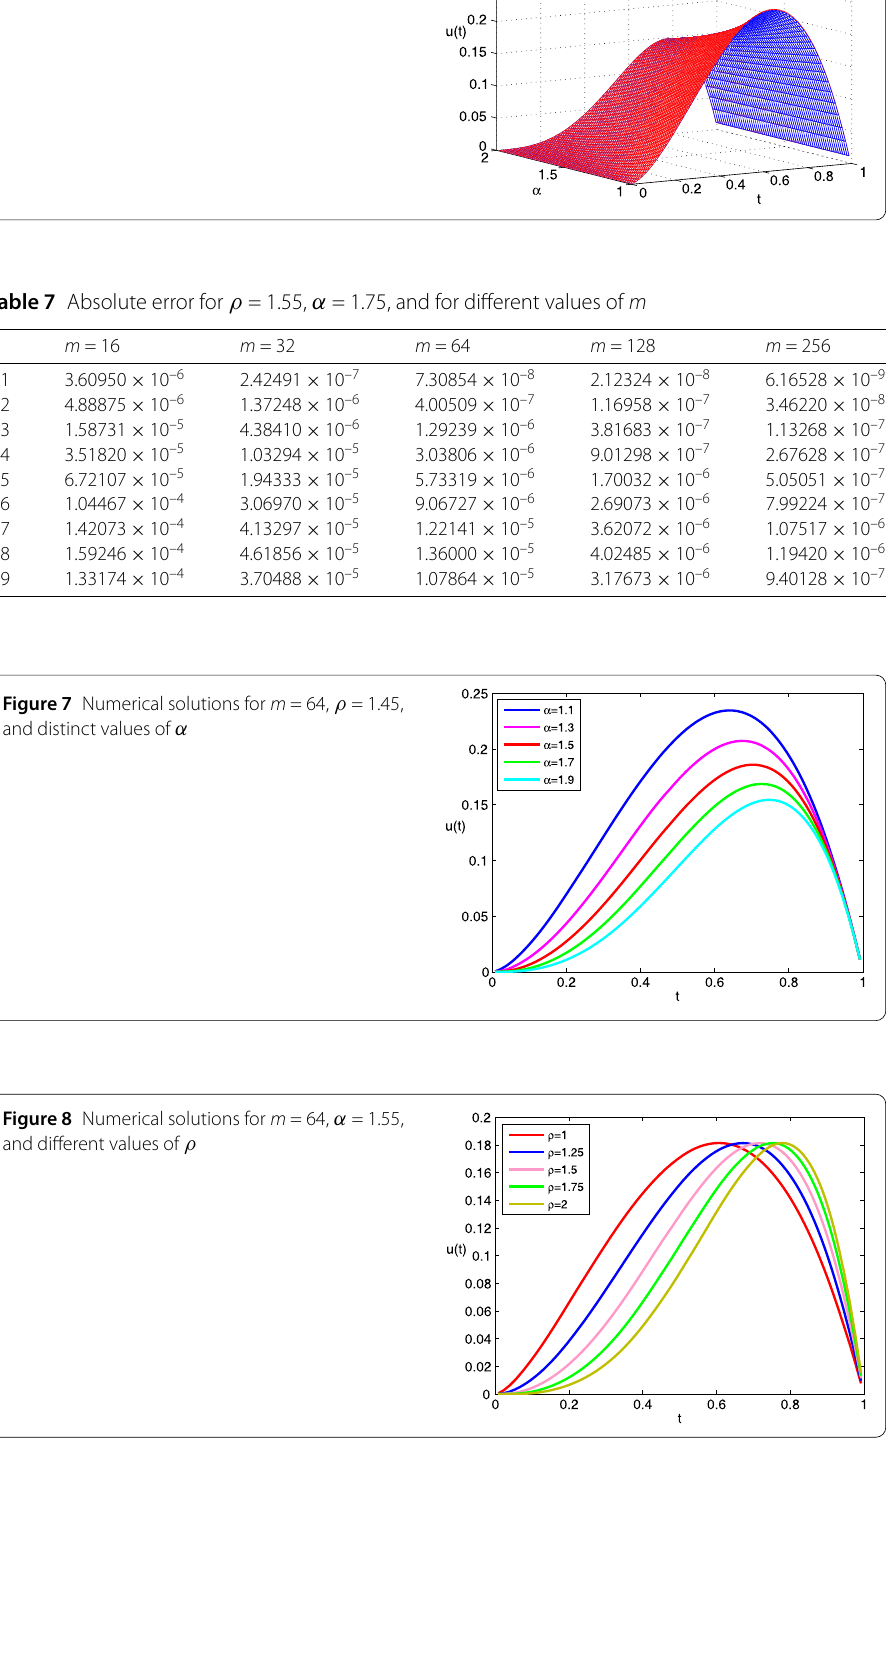
Figure 6 Exact and numerical solutions for m = 64, ρ = 1.55, and different values of α